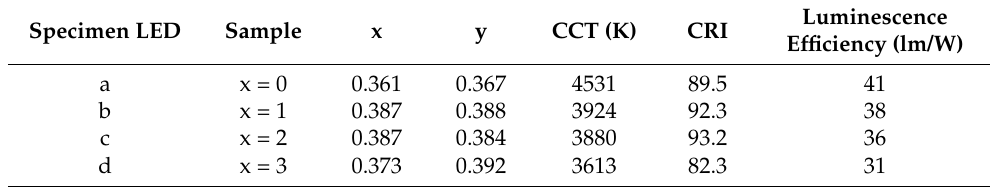
Table 2. The LuAGG: Ce 3+ (x = 0, 1, 2, 3) test sample with white LED parameters. Specimen